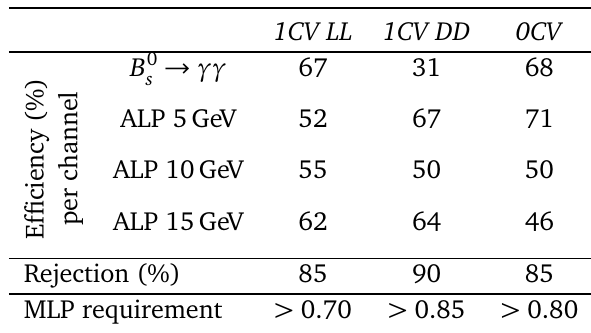
Table 5: Percentage efficiency for the B 0 structed and loosely selected